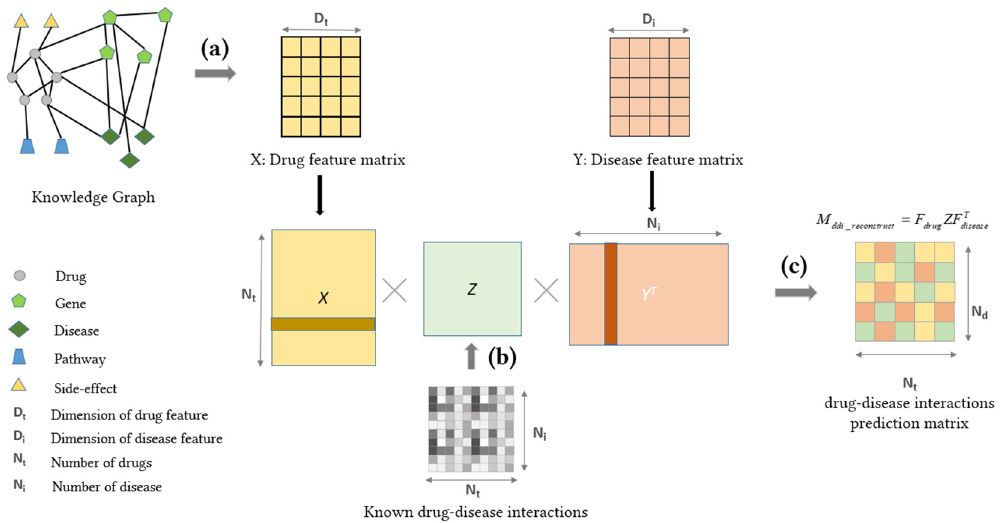
Figure 2. The workflow of the Graph Convolutional Network with Attentional mechanism for Drug–Disease Interaction